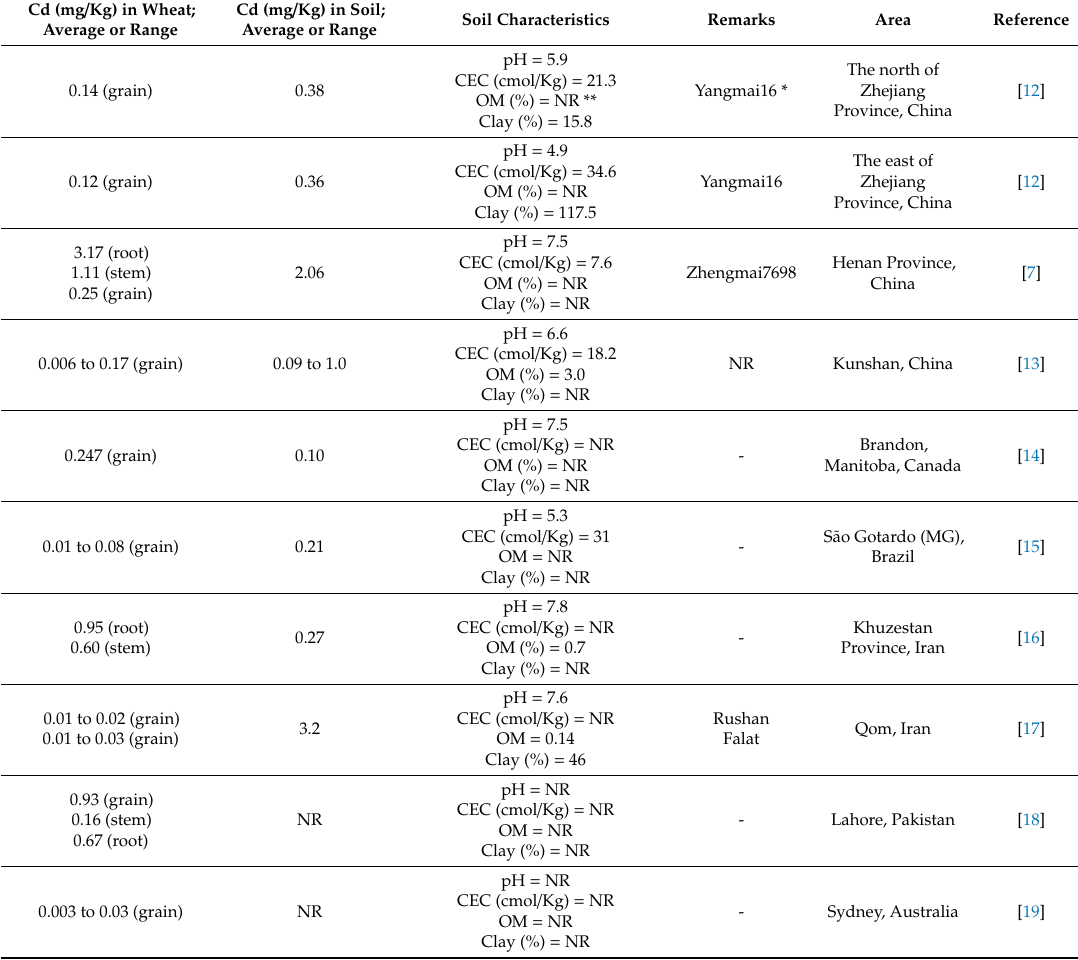
Table 1. Cd concentration in wheat and soil